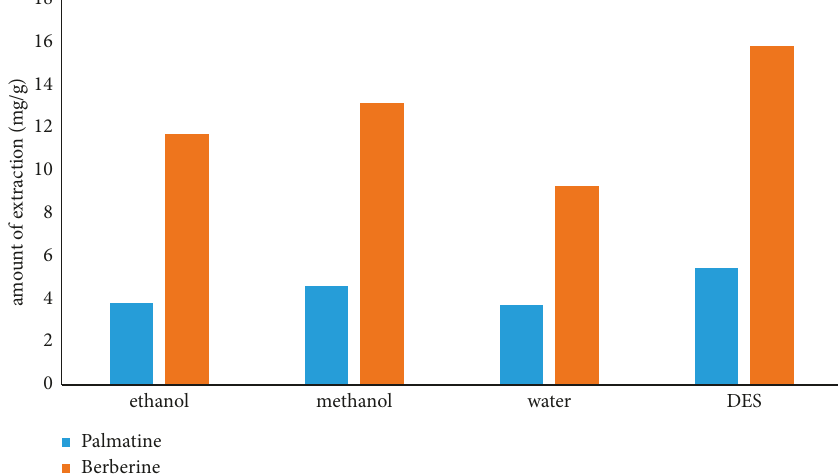
Figure 4: Comparison with traditional extraction solvents in ultrasound-assisted